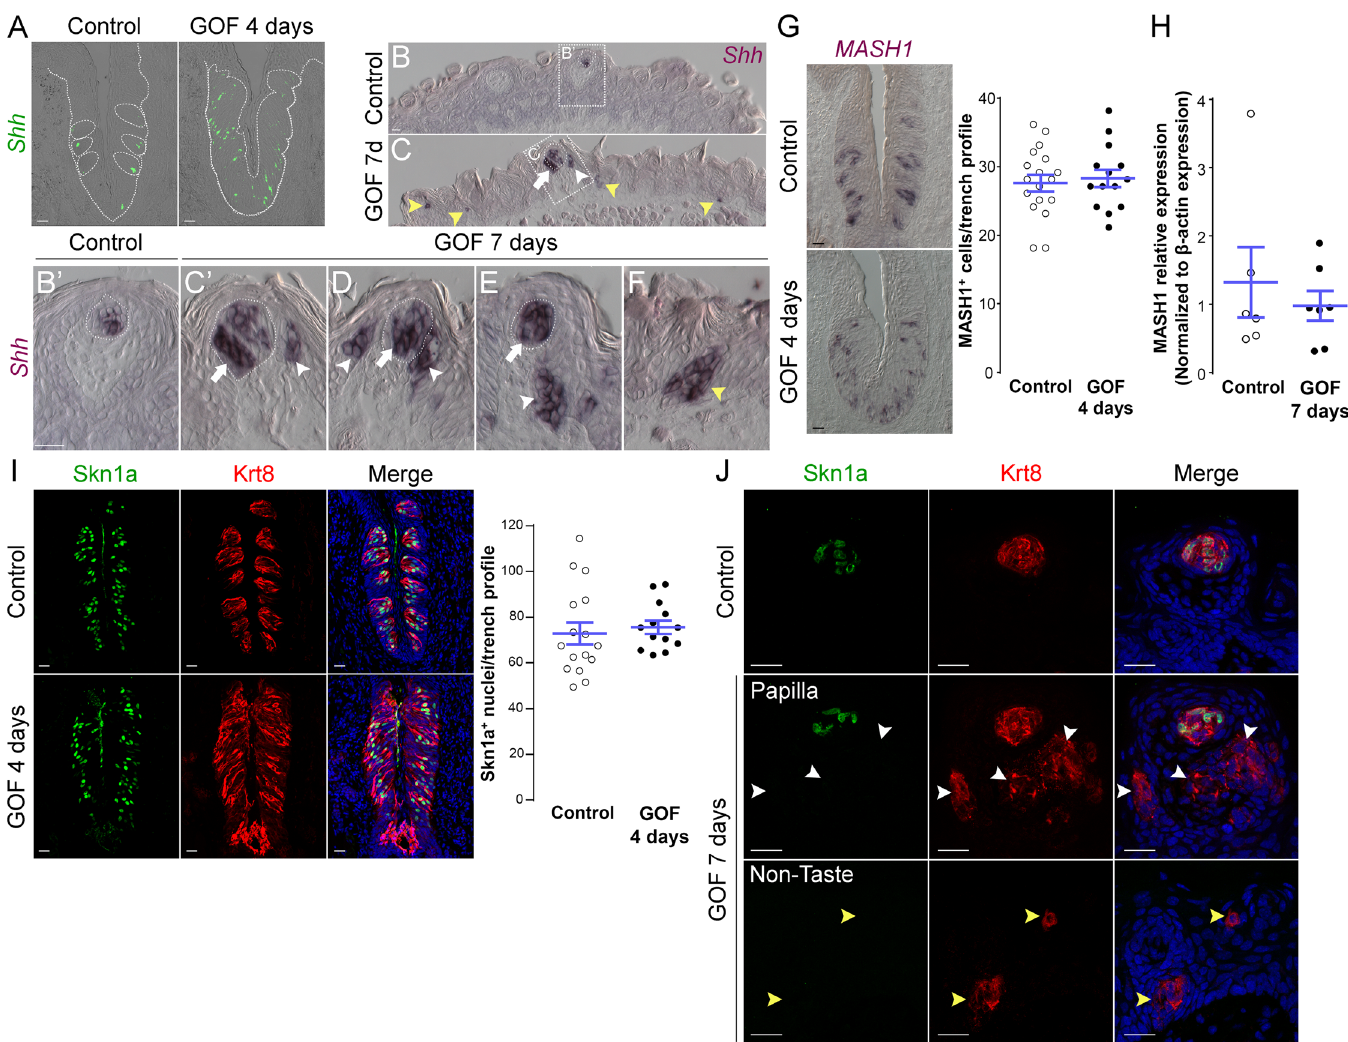
Fig 6. Stabilized β -catenin increases the number of Shh + precursors of all three taste cell types, but does not impact specific precursors of Type II or III cells. A . In control mice, 1 – 3 Shh + basal cells (green) are located in the basal compartment of each taste bud section (dashed circles), whereas in the CVP of mutant mice fed dox chow for 4 days, Shh + cells (green) are increased and widespread in the expanded taste epithelium (dashed line). B,B ’ . In the anterior tongue of control mice, Shh + cells are restricted to FFP taste buds. C-F . In stabilized β -catenin mutants following 7 days on dox, in addition to endogenous Shh + cells (white arrows), ectopic Shh + cells are detected in FFP epithelium (white arrowheads in C,C ’ ,D,E ), as well as in non-taste epithelium adjacent to filiform papillae (yellow arrowheads in C,F ). MASH1 and Skn-1a are expressed in subsets of basal cells within taste buds, and regulate the Type III and Type II cell lineage, respectively. CVP sections of control and mutant mice after 4 days on dox showed that Mash1 + ( G ) and ( I ) Skn-1a + (green) cell numbers were not altered by β -catenin stabilization. Real-time RT-PCR on the anterior tongue epithelium showed no difference in the expression of MASH1 between controls and mutants ( H ). J . After 7 days on dox chow, Skn-1a + cells (green) were restricted to endogenous FFP taste buds in control and mutant mice (Krt8 + red, arrow). In mutants, Skn-1a + cells were not detected in ectopic Krt8 + clusters in FFP epithelium ( J , white arrowheads) or non-taste epithelium ( J , yellow arrowheads). Nuclei were counterstained with DRAQ5 in blue. Dotted line indicates the basement membrane, and dashed circles indicate taste buds. Representative stack images and data from 3 control and 3 mutant mice. Data are represented as a scatter plot (individual symbols), and mean ± SEM (blue bars). Student ’ s t-test. Scale bars = 20 μ